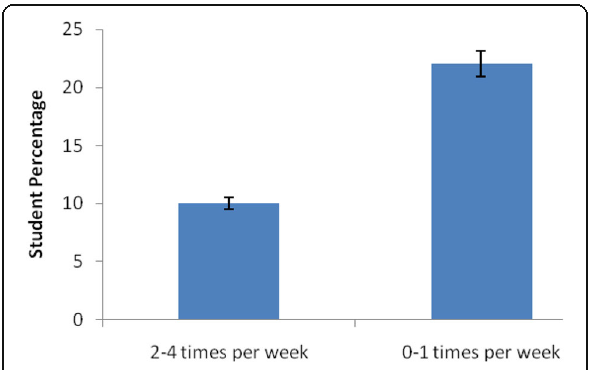
Fig. 1 Frequency of exercise (10 ± 0.5 reported 2 – 4 times per week, while 22 ± 1.1 reported 0 – 1 times per week) Fig. 3 Types of snacks eaten (sweets: 76 ± 3.8; others: 24 ±